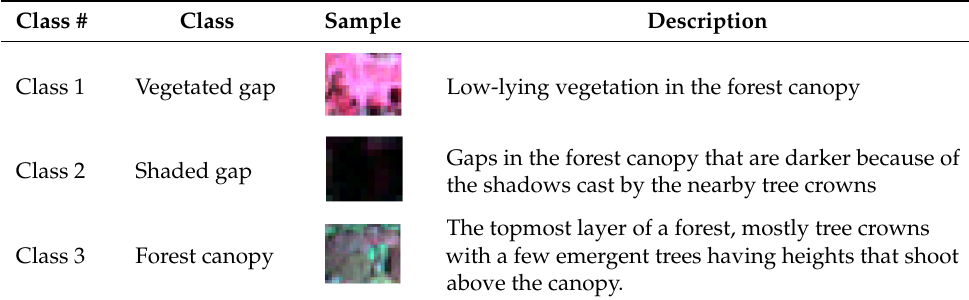
Table 1. Reference data and their description.